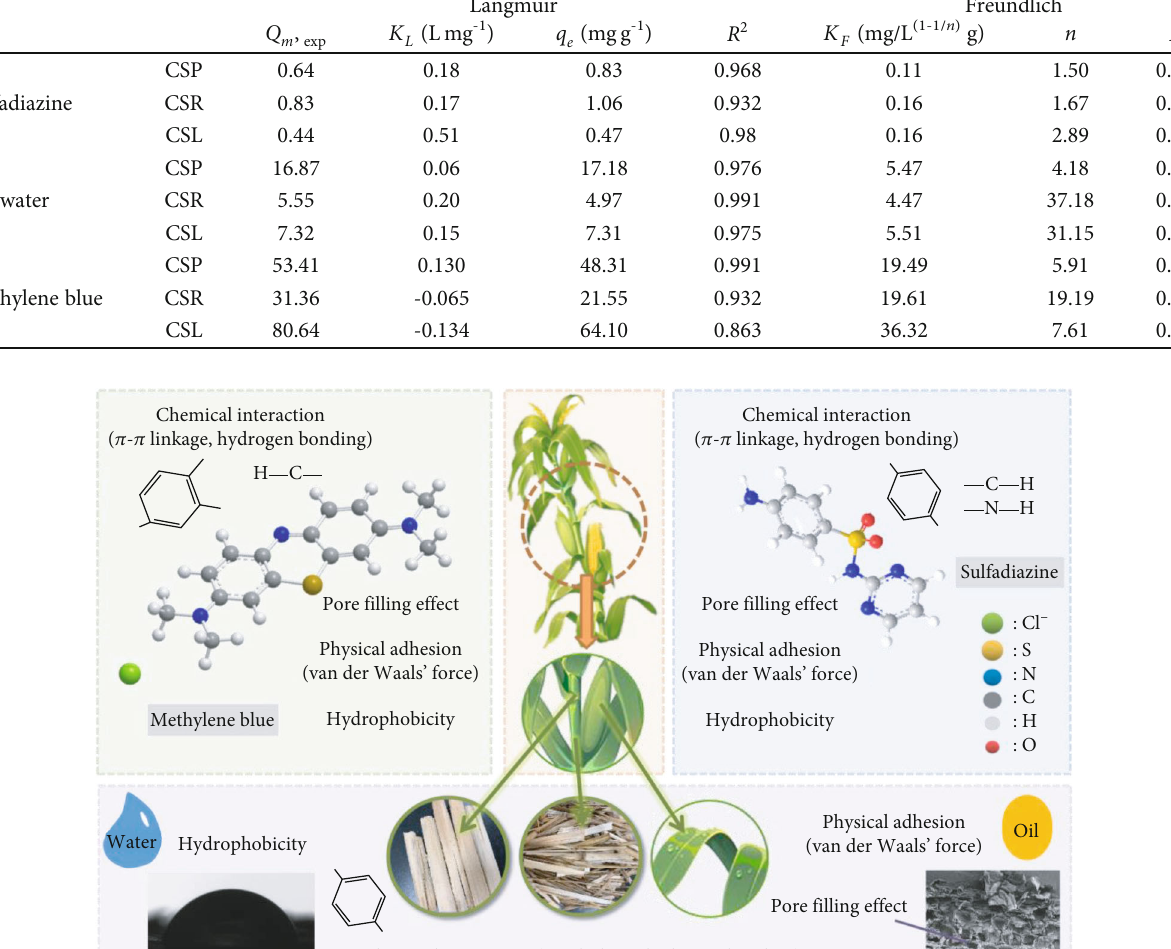
Table 7: Isotherm constants for adsorption of sulfadiazine, oil-water, and methylene blue onto di ff erent adsorbents.